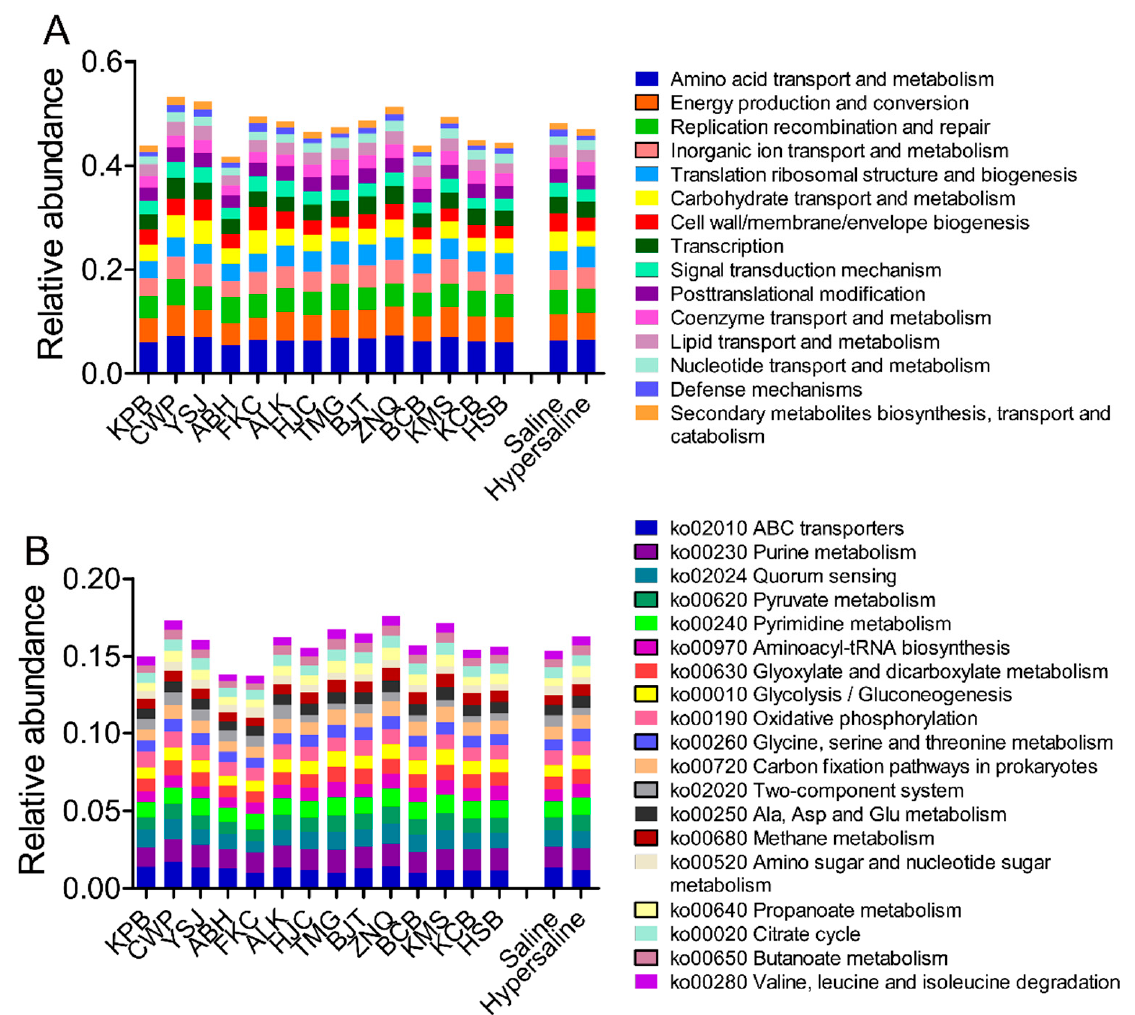
Figure 5. Relative abundance of genes annotated in COG at level 1 ( A ) and KEGG at level 3 ( B ) of microbial communities in each site, and combined saline and hypersaline soils.